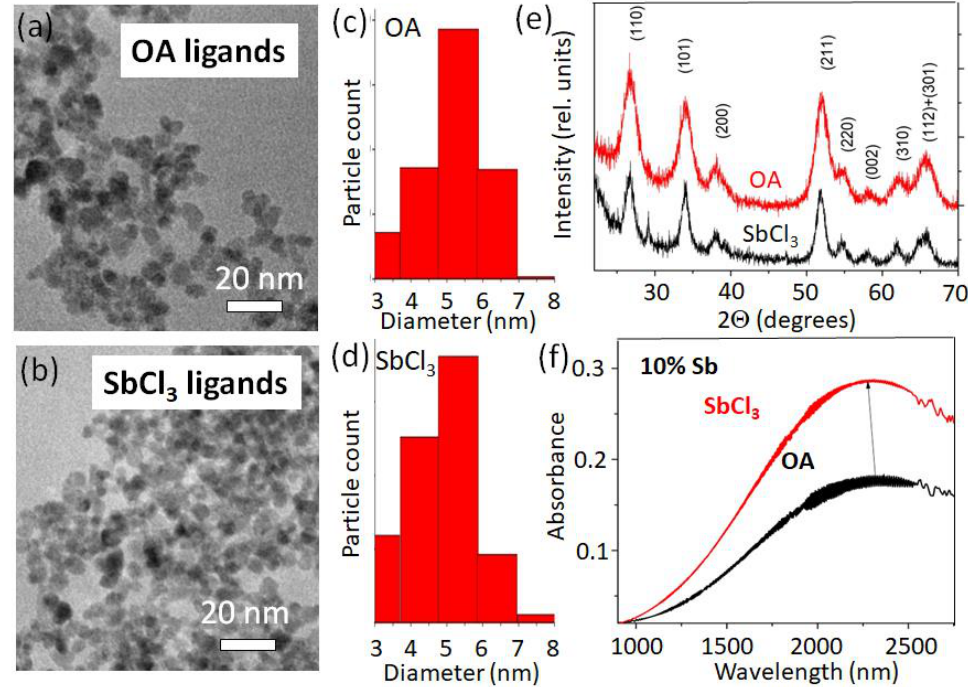
Figure 5. ATO NCs upon ligand exchange to SbCl 3 . ( a , b ) TEM images of 20% doped ATO NCs before and after ligand exchange with ( c , d ) their corresponding size distributions and ( e ) X-ray diffraction spectra. ( f ) LSPR shift of ATO NCs with a 10% doping concentration upon ligand exchange.